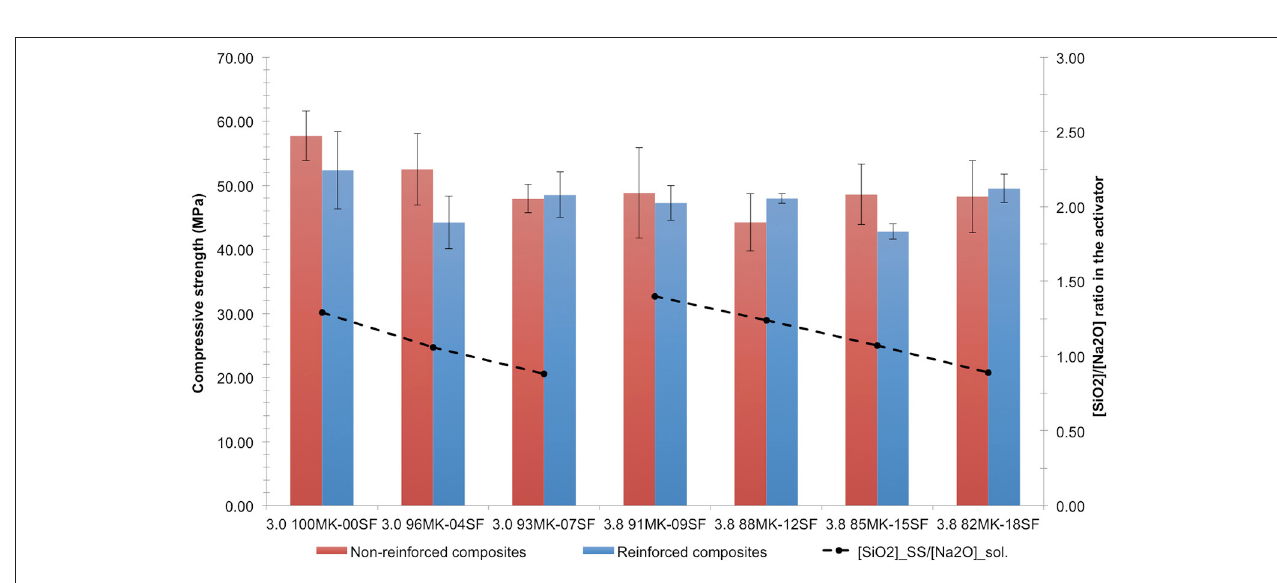
FIGURE 4 | Flow table test results for the fiber-reinforced mortars.